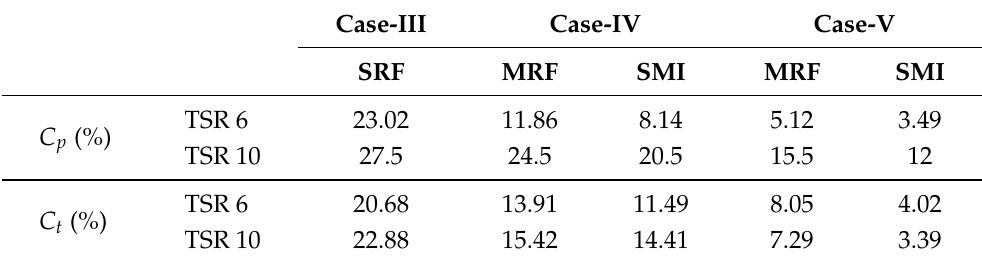
Table 3. HAWT-S826: Comparison of cases for the rotating rotor cases, (i.e., Case-III: 120 ◦ blade, Case-IV: 120 ◦ rotor, and Case-V: complete turbine structure including the nacelle and tower) to quantify the error in the power coefficient ( C p ) and thrust coefficient ( C t ). The error was calculated against the experimental data at a TSR of 6 and